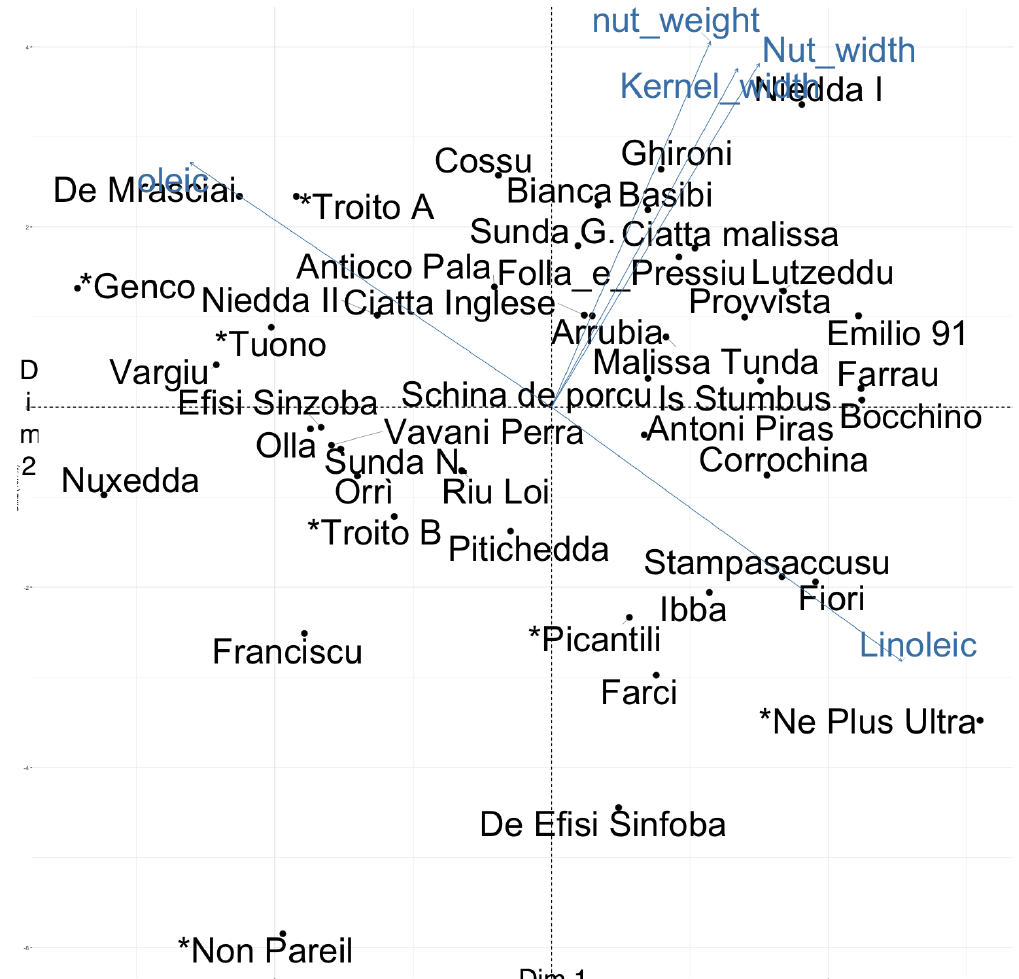
Figure 1. Biplots of individuals and variables in the principal component analysis (PCA) components 1 and 2. Only the five variables giving the highest contributions are shown. The names of reference cultivars are preceeded by an